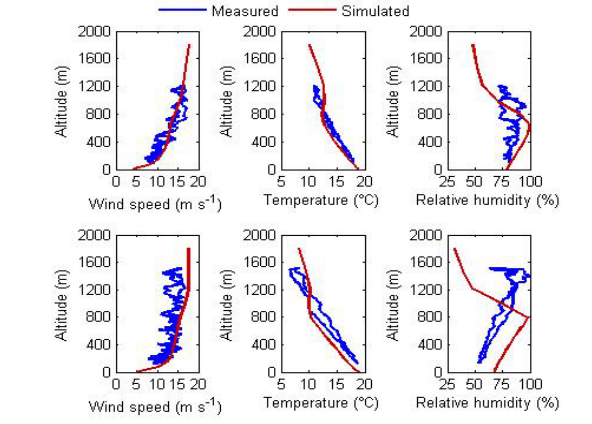
Figure 3. Measured and simulated vertical profiles of the atmosphere; morning profile No. 4 (upper plates) and noon profile No. 5 (lower plates). See Table 2 for details.